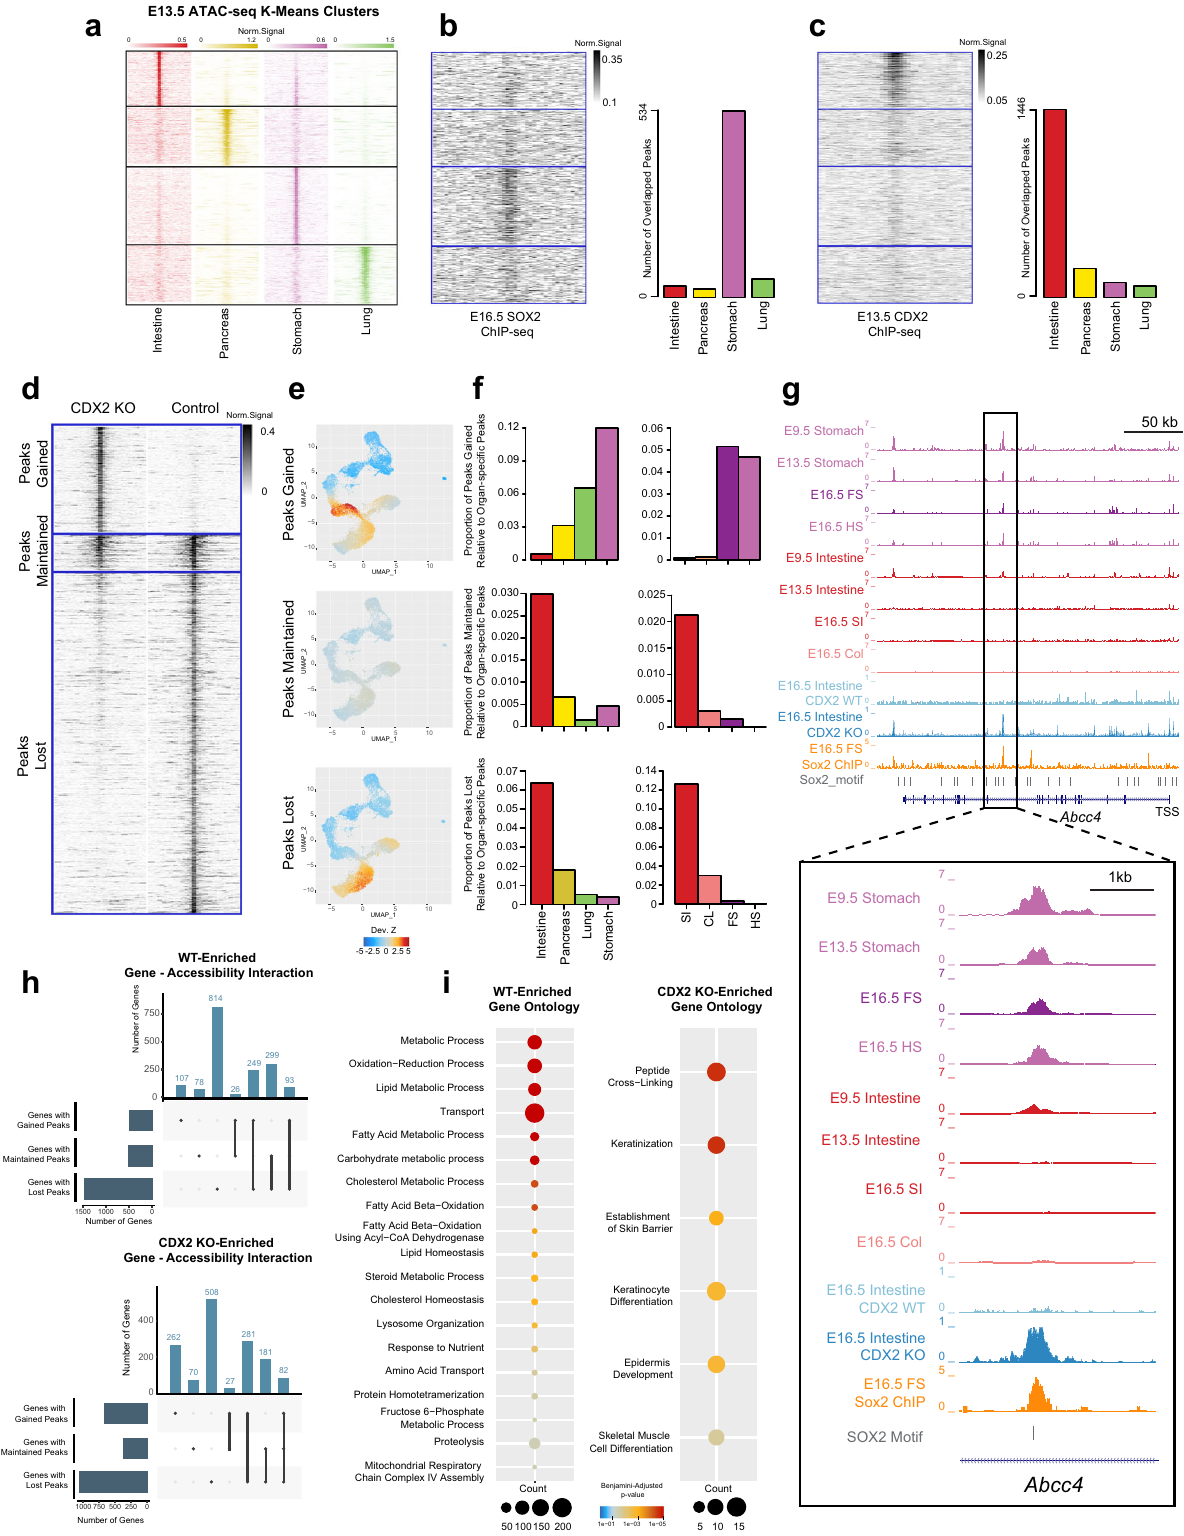
accessibility levels in the peak regions in each cell compared to all cells using chromVAR 39 (see “ Methods ” ), and marked the cell- level enrichment on the scATAC-seq UMAP (Fig. 3e, Figure S9b). In the Sox2 KO stomach, we observed that gained peaks are strongly associated with the chromatin accessibility pattern of the cell clusters projected as stomach and lung, and that maintained